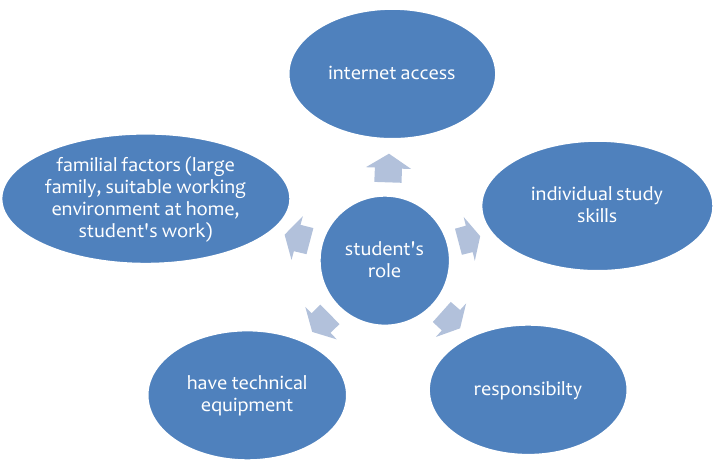
Figure 3: Factors affecting the student's